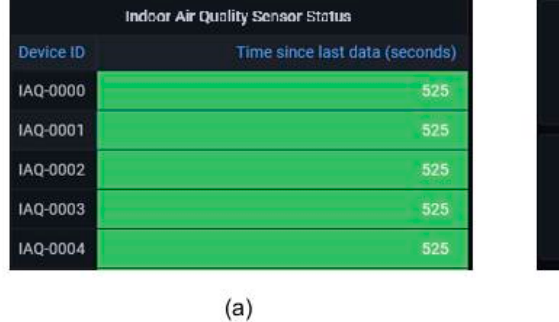
15 of 26 Figure 11. Barometric pressure sensors and door sensors. ( a ) Panel shows the locations and latest